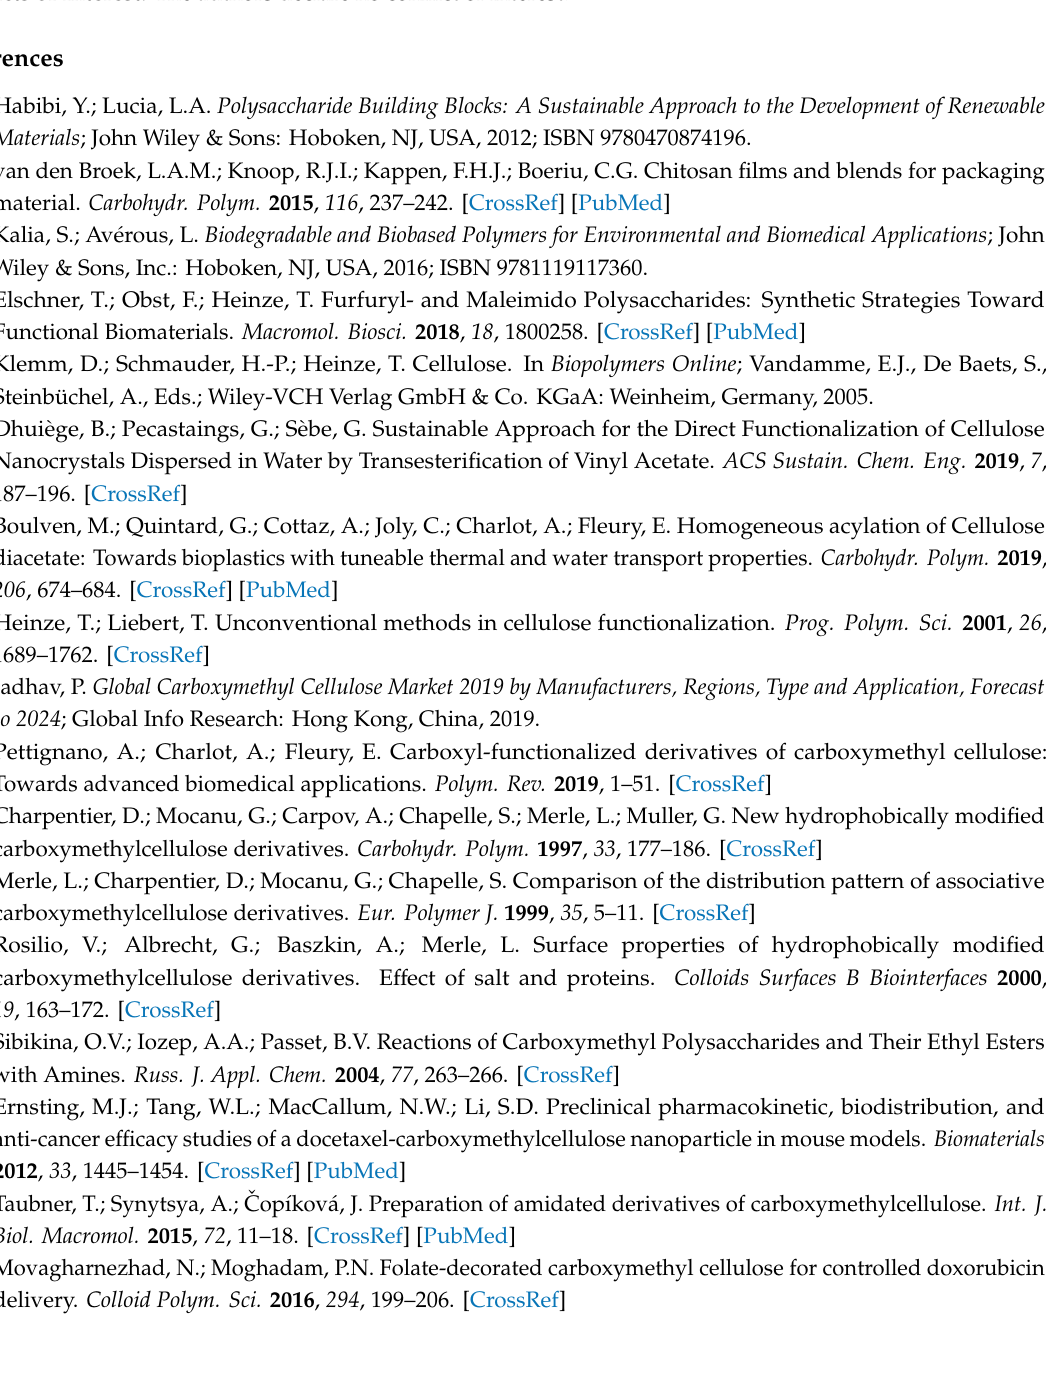
Figure S11: Evolution of moduli E’ (- -) and of the loss tangent (tan δ ) (—) as a function of temperature for a film made from NaCMC (Table 1, Entry